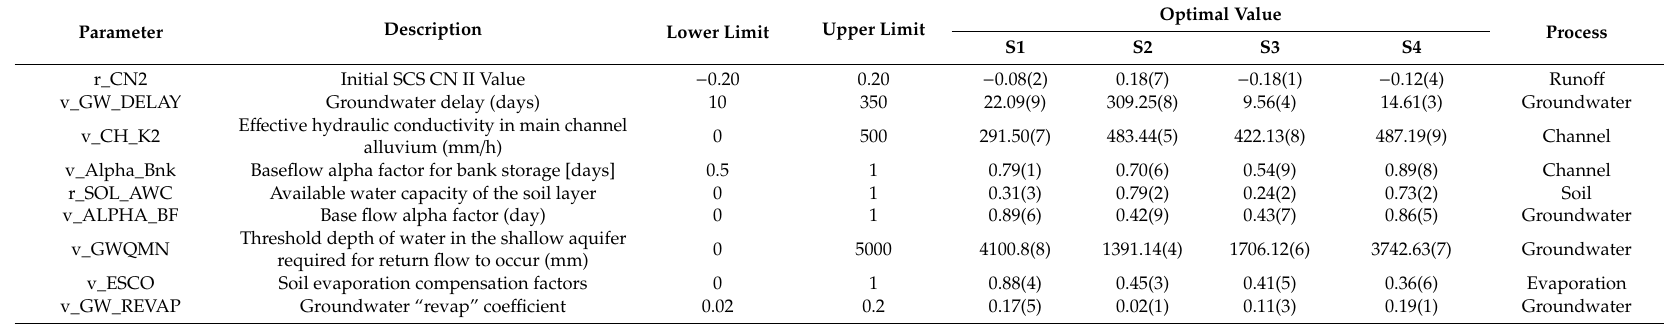
Table 2. The optimised value of each sensitive parameter for the four scenarios (“v_” and “r_” stand for replacement and a relative change to the initial parameter values,